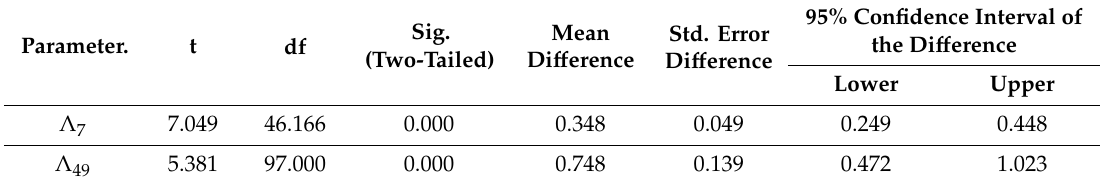
Table 5. Independent samples t -test for the groups of the H subjects and CHF patients (PPG method).